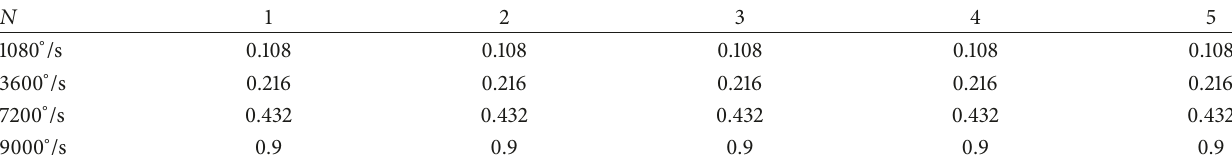
Table 5: Angular increment by real-time